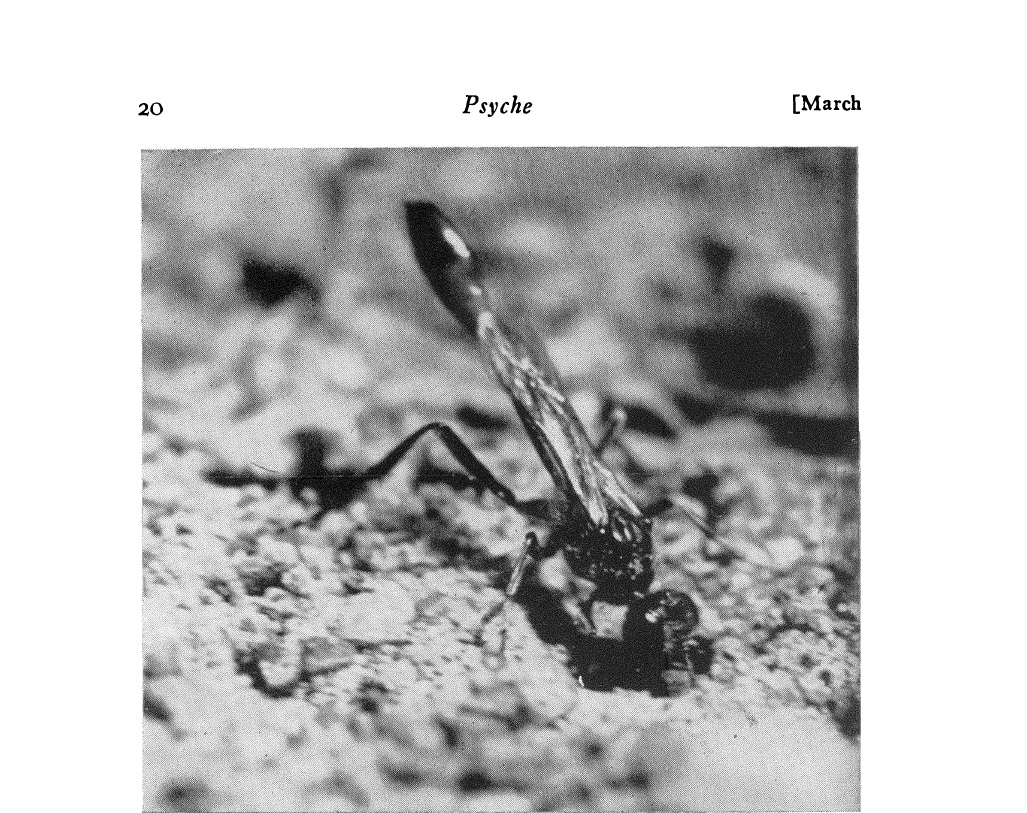
Fig. 8. Female A mmophila azteca at final closure of her nest. A small pebble is being held in the mandibles and used for packing soil in the filled